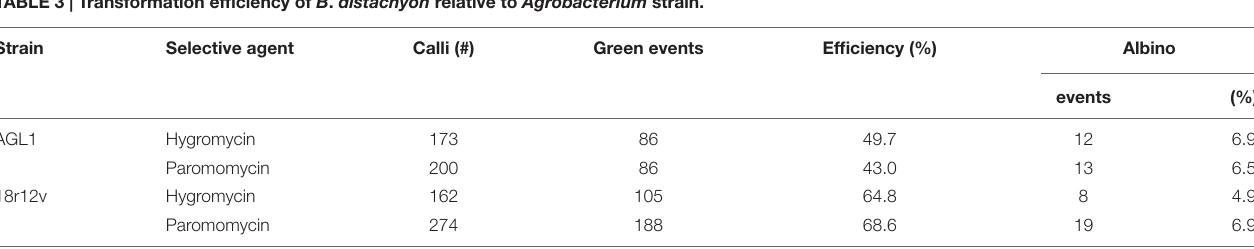
TABLE 3 | Transformation efficiency of B . distachyon relative to Agrobacterium strain.